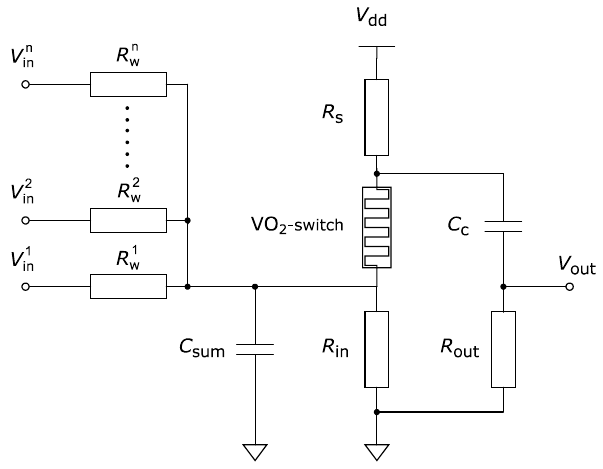
Figure 2. Electrical circuit of a VO 2 neuron.